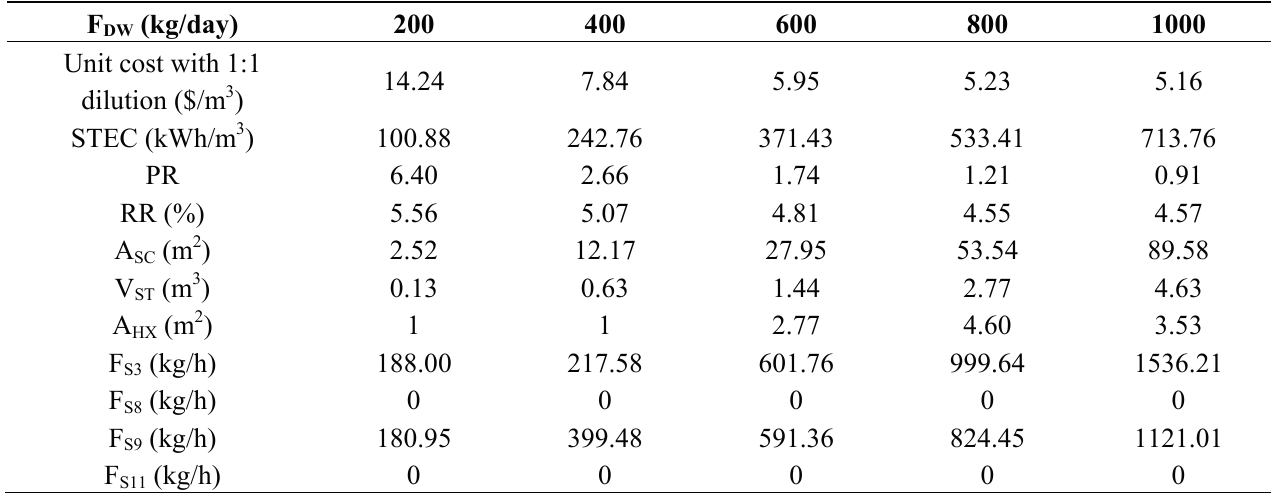
Table 4. Optimal solutions for the AGMD-2 system.